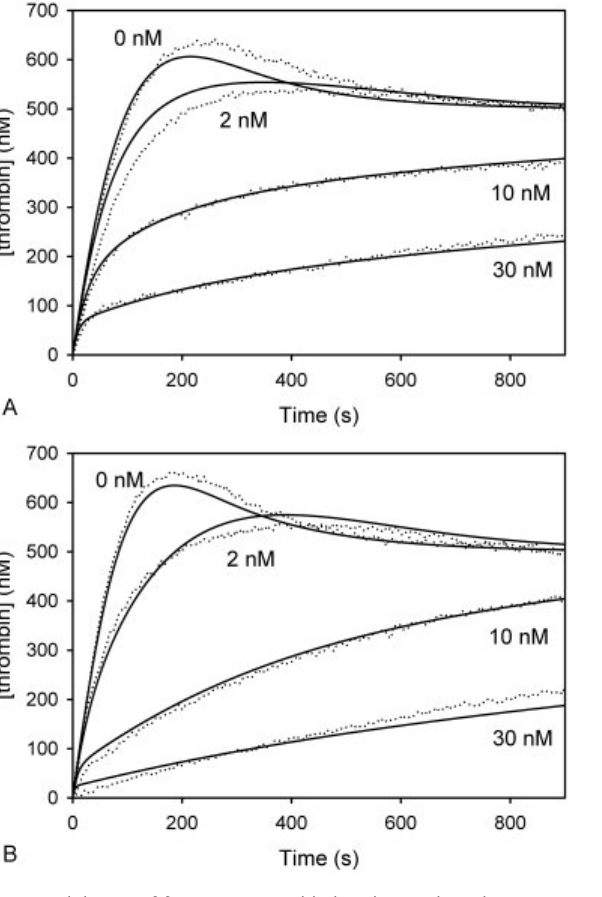
Fig. 6 Inhibition of factor Xa assembled in the prothrombinase complex by the presence of apixaban and rivaroxaban. Activation of 500 nM prothrombin by 0.5 nM prothrombinase (0.5 nM factor Xa, 5 nM factor Va, 50 µM PCPS, 5 mM CaCl 2 ) containing ( A ) apixaban or ( B ) rivaroxaban at varying concentrations (2, 10, or 30 nM) was monitored using DAPA in a fl uorescent plate reader at 37°C. Thrombin generation was monitored at 2-s intervals. Data were fi t to a mixed inhibition model (lines).